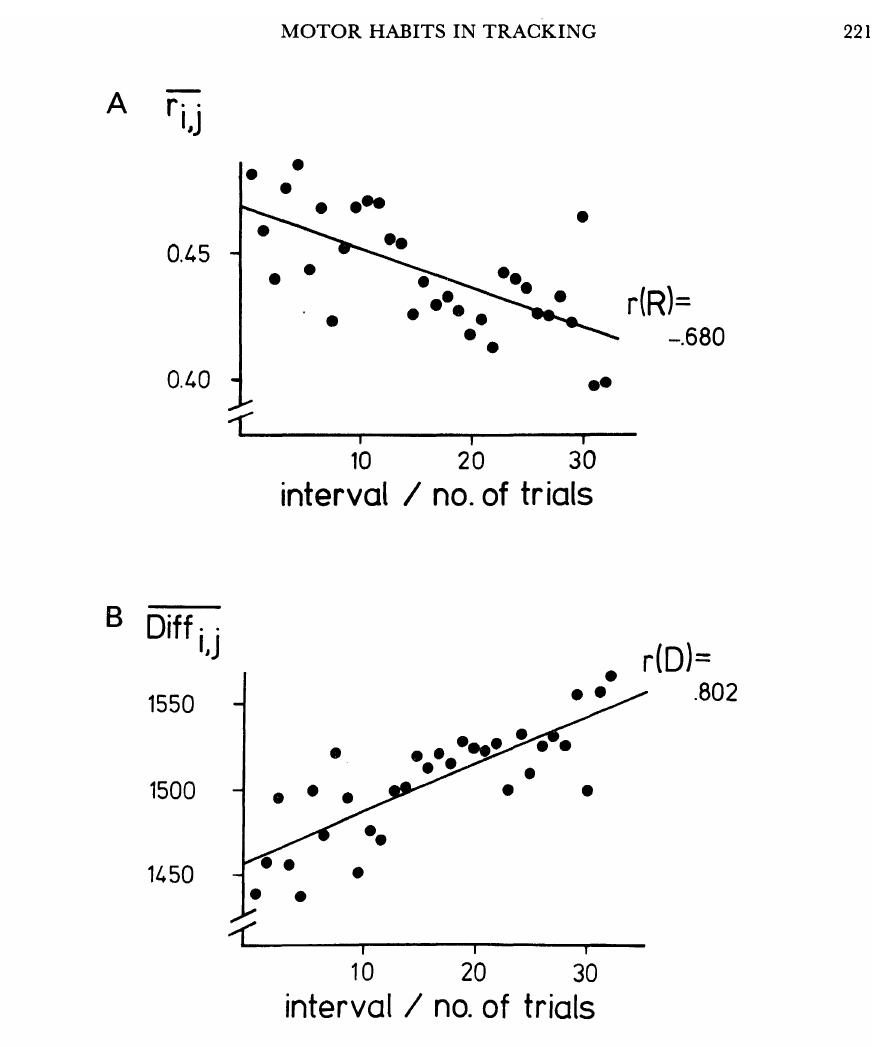
FIG. 2. Autocorrelation plots from single experiments (64 trials) of random pursuit tracking (experiment I, subject I in Table 1). The error curves of trials within the experiment are compared either by point-to-point linear regression (A) or cumulated point-to-point difference (B). Abscissa: interval (in number of trials) between trials to be compared. Ordinates: mean correlation coefficient (A) and mean accumulated point-to-point difference (B). The autocorrelation plots are approxi mated by linear regression, correlation coefficients in these experiments being significantly different from zero (p < ·00